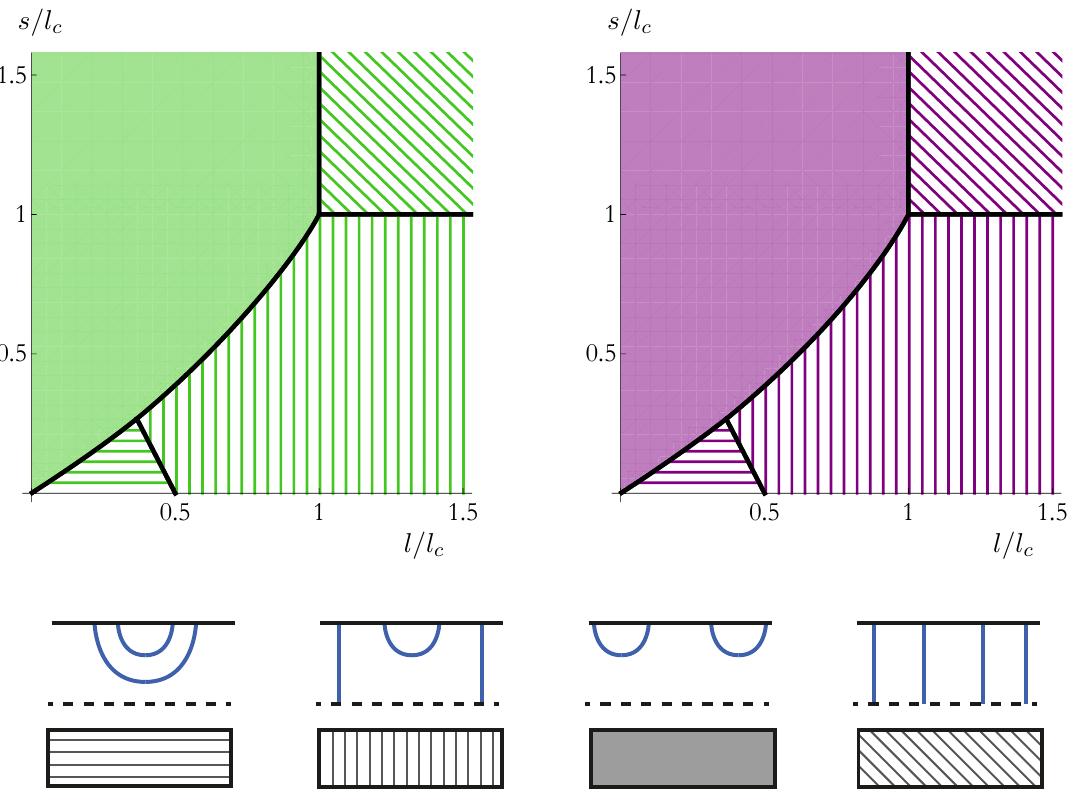
Figure 6. Phase diagram of mutual information of entanglement entropy of strips in the gapped non-confining theory B 0 (Left) and the confining one B conf (Right). Solid black curves consist 8 8 of points where mutual information (3.16) vanish and a phase transition takes place. Separation between strips s is shown in the vertical axes and their width l is shown in the horizontal axes, both quantities normalized to the value of the width l at which the “disconnected” configuration c t becomes dominant in each